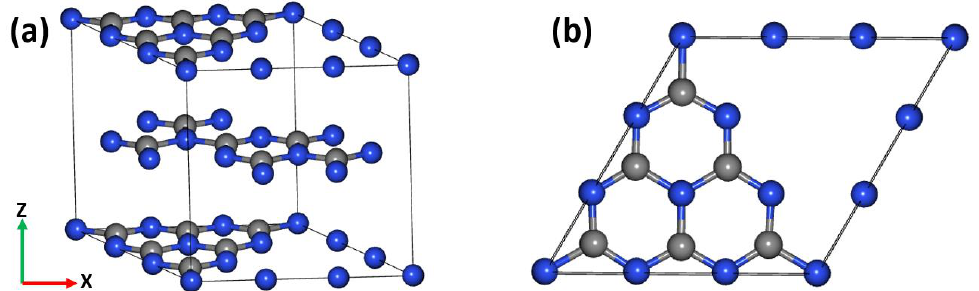
Figure 2. Geometric structure of heptazine-based gCN: ( a ) bulk; ( b ) monolayer. (C and N atoms are in black and blue respectively).